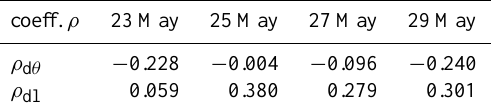
Table 3. Changes of the relationship between soil layering and soil water dynamics at different mapping times relative to 22 May. ρ d θ and ρ dl are the correlation coefficients between the reflector depth and the changes of soil water content and the total soil water vol- ume, respectively. All values are significant at p-level 0.01 except the ρ d θ on 25 May. coeff.